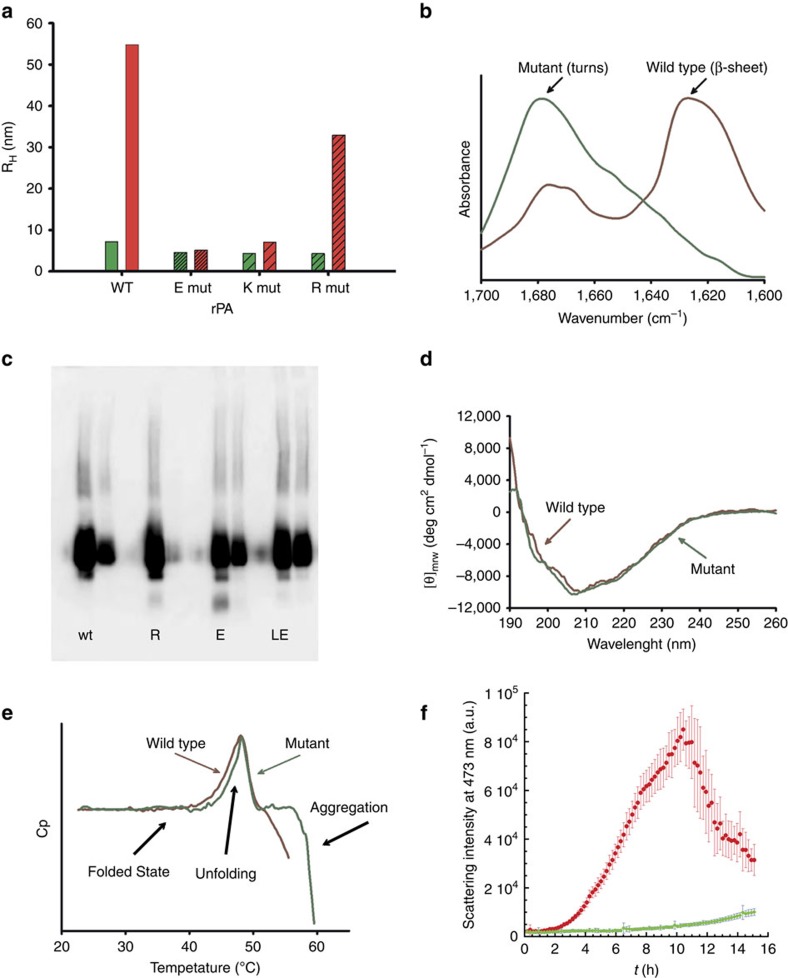
Comparison of the aggregation behaviour of WT and mutant PA.(a) The hydrodynamic radius (RH) of WT and single Gk mutant PA before (green bar) and after exposure (red bar) to thermal stress at 45 °C for 30 min. (b) Infrared amide I band of the WT (NATNIYTVLDKIK) and mutant sequence (NATNIYEVLDKIK) surrounding the mutation site of PA APR 1. (c) Western blot of WT, single and double mutant PA before and after exposing to thermal stress at 45 °C for 30 min. The lanes 1 and 2 of each sample represent the soluble fraction of PA under normal conditions (25 °C) and after thermal heat stress (40 °C for 30 min). (d) Far UV circular dichroism (CD) spectra of the WT and double-mutant (T576E/S559L) PA at 25 °C. (e) DSC thermogram of WT (red) and double-mutant (T576E/S559L) PA (green). (f) Static light scattering (SLS) at 473 nm measured over time for WT (red) and double-mutant (T576E/S559L) (green) at 40 °C.